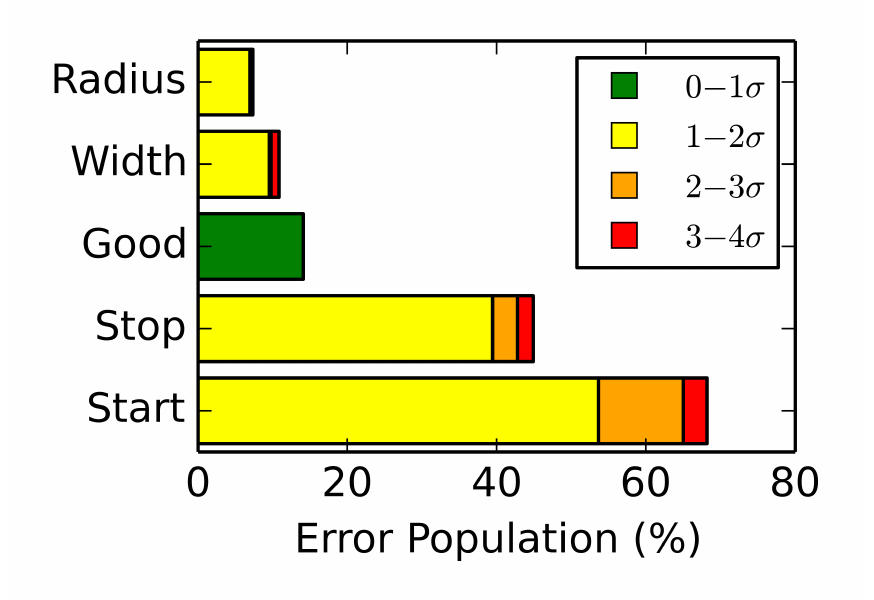
Figure A9. Frequency error count of a single print job. Each color denotes the standard deviation and the bar denotes the percentage of spirals in the set that have a defect (center radius, arm width, stop, and start) and percentage of good spirals is noted in